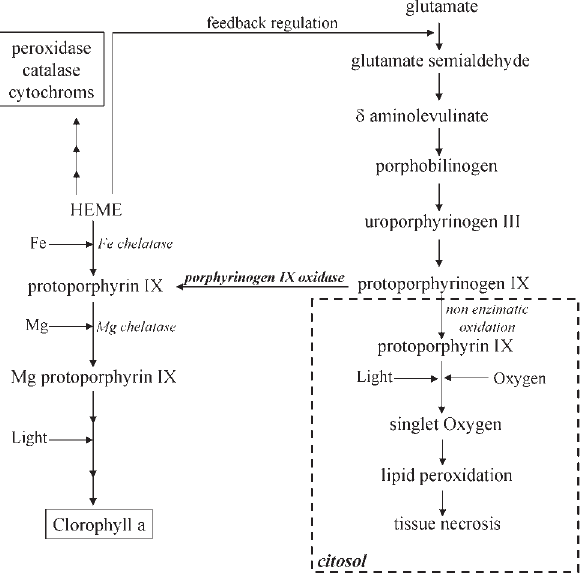
Figure 1 - Synthesis route of porphyrins in plants (adapted from Dodge, 1991; Hess, 1993; Nelson and Leningher, 2000; Weller,